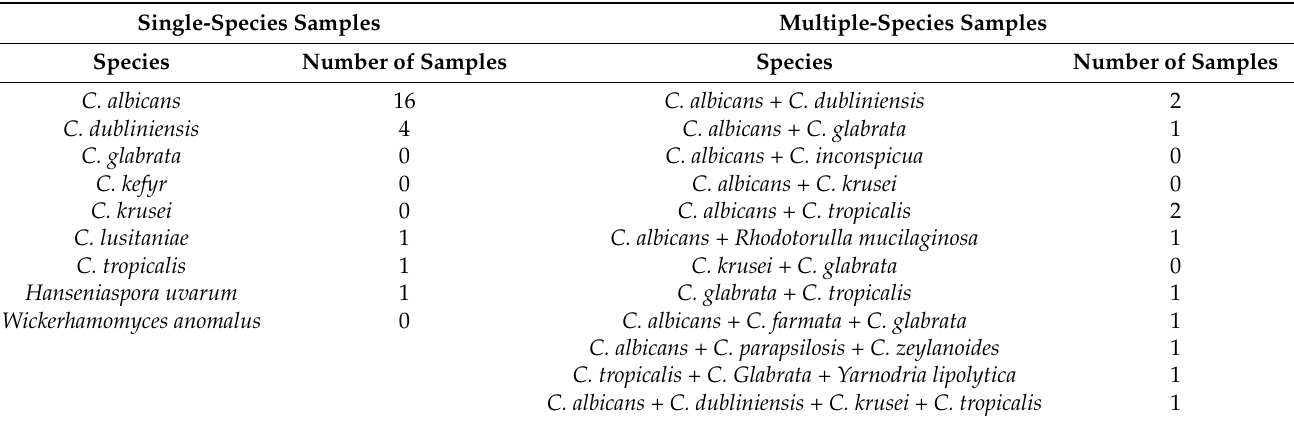
Table 3. Cultured species of fungi in samples taken from the control